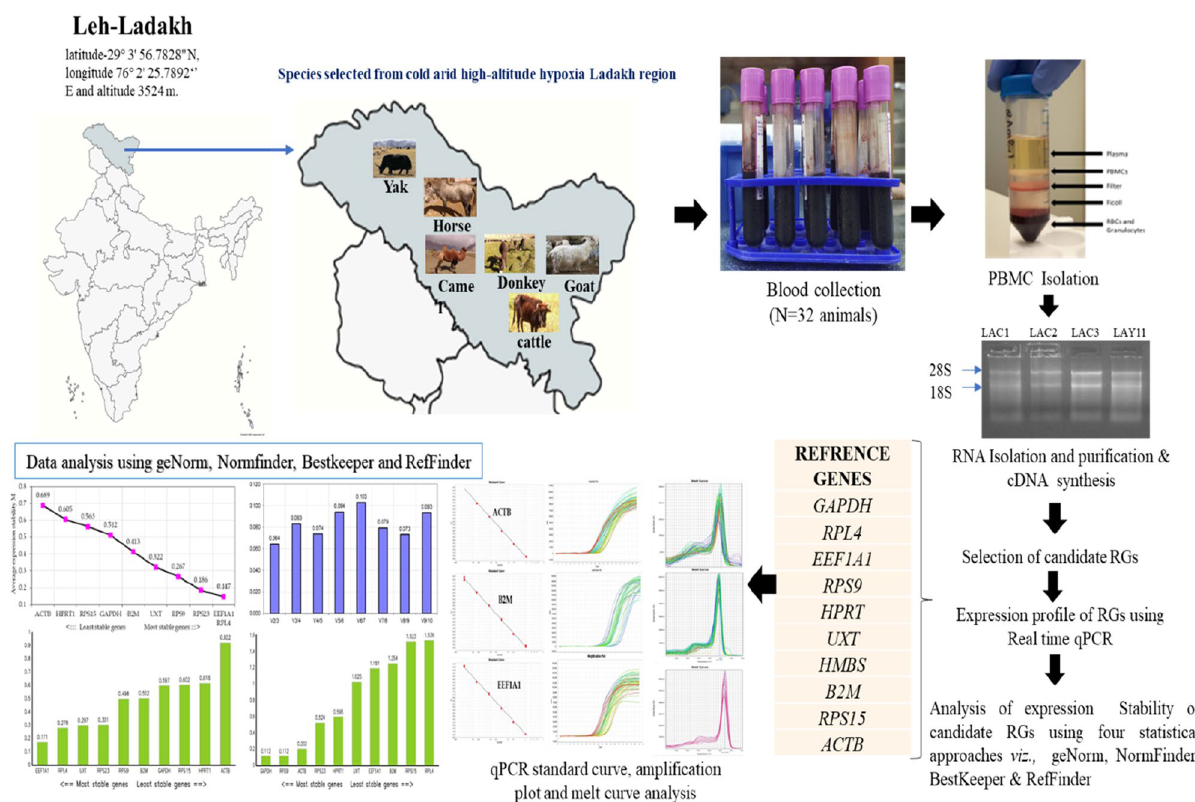
Figure 3. The entire workflow of the qPCR experiment conducted in PBMCs of different species adapted to cold arid hypoxia environment. Maps was made using Mapchart (https:// www. mapch art. net/ india.